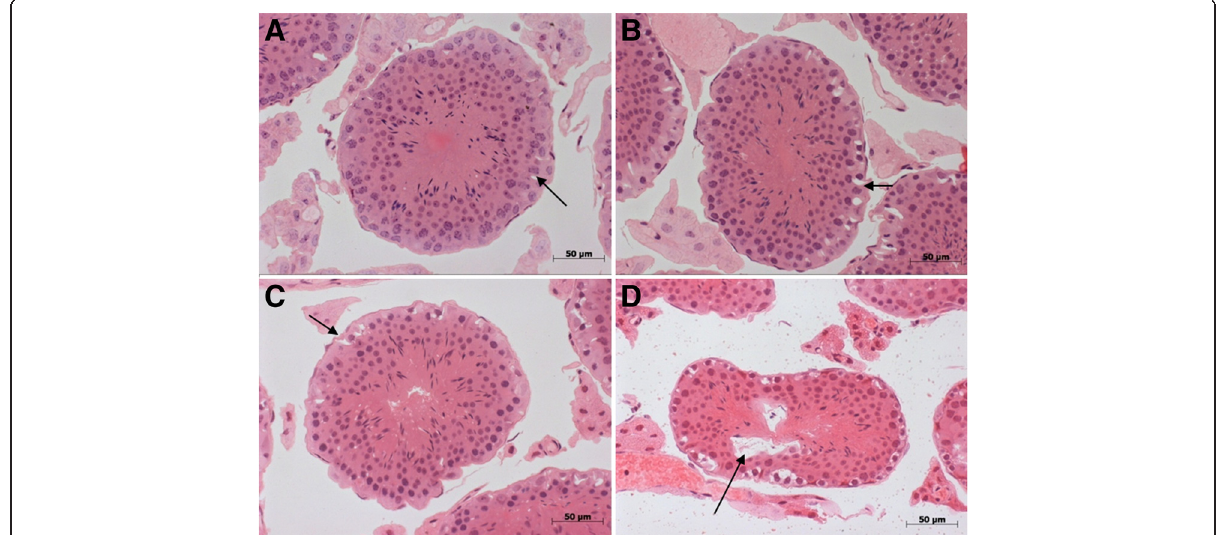
Figure 4 Maintenance of the blood-testis barrier (BTB) in male adult mice treated with vehicle, captopril or BPP-10c. Photomicrographs of 0.5- μ m thick – plastic-embedded transverse sections of (A) vehicle, (B) captopril, (C) BPP-10c and (D) LPS – of seminiferous tubules following fixation with hyperosmotic fixative and staining with hematoxylin and eosin. The adluminal meiotic cells are protected from fixative-induced condensation, maintaining normal morphology and cellular contacts in A , B and C (arrow). The BTB is not maintained in the seminiferous tubules of mice treated with LPS ( D , see